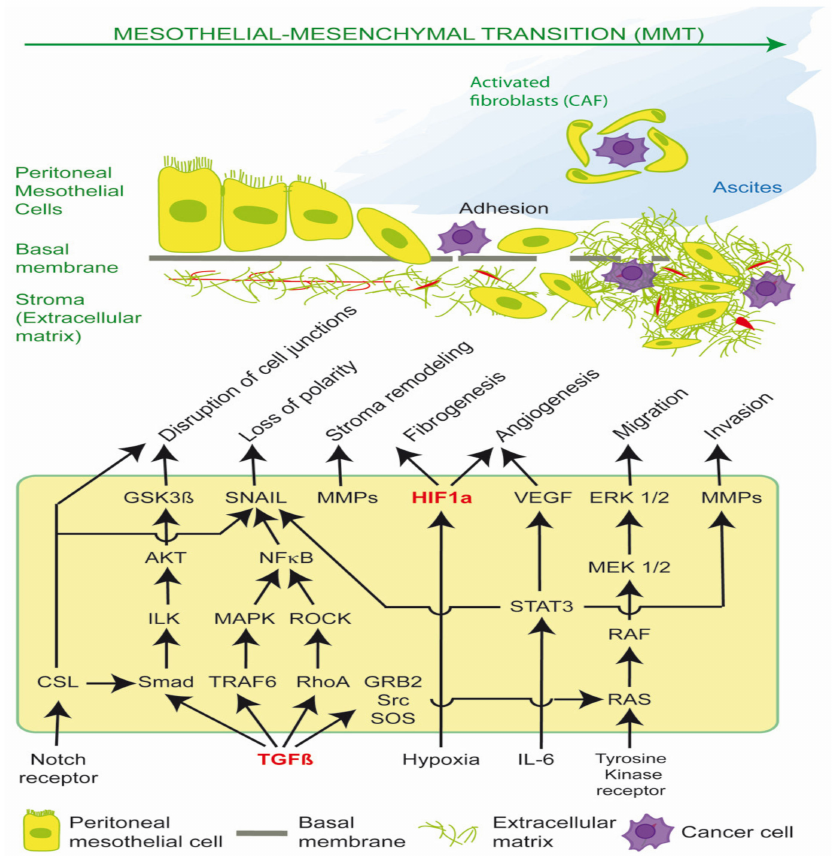
Figure 1. Transforming Growth Factor β 1 (TGF- β 1) and Hypoxia-inducible factor (HIF) signaling pathways in EPS and PM. Activation of these pathways results in mesothelial-mesenchymal transition (MMT) of peritoneal mesothelial cells into activated fibroblasts in encapsulating peritoneal sclerosis (EPS), and cancer associated fibroblasts (CAFs) in peritoneal metastasis (PM). CAFs have reciprocal receptor tyrosine kinase activation and metabolic coupling with cancer cells in the tumor microenvironment. CAFs form tumor spheroids with epithelial cancer cells, promote ascites and transcoelomic metastasis, and facilitate basement membrane / extracellular matrix